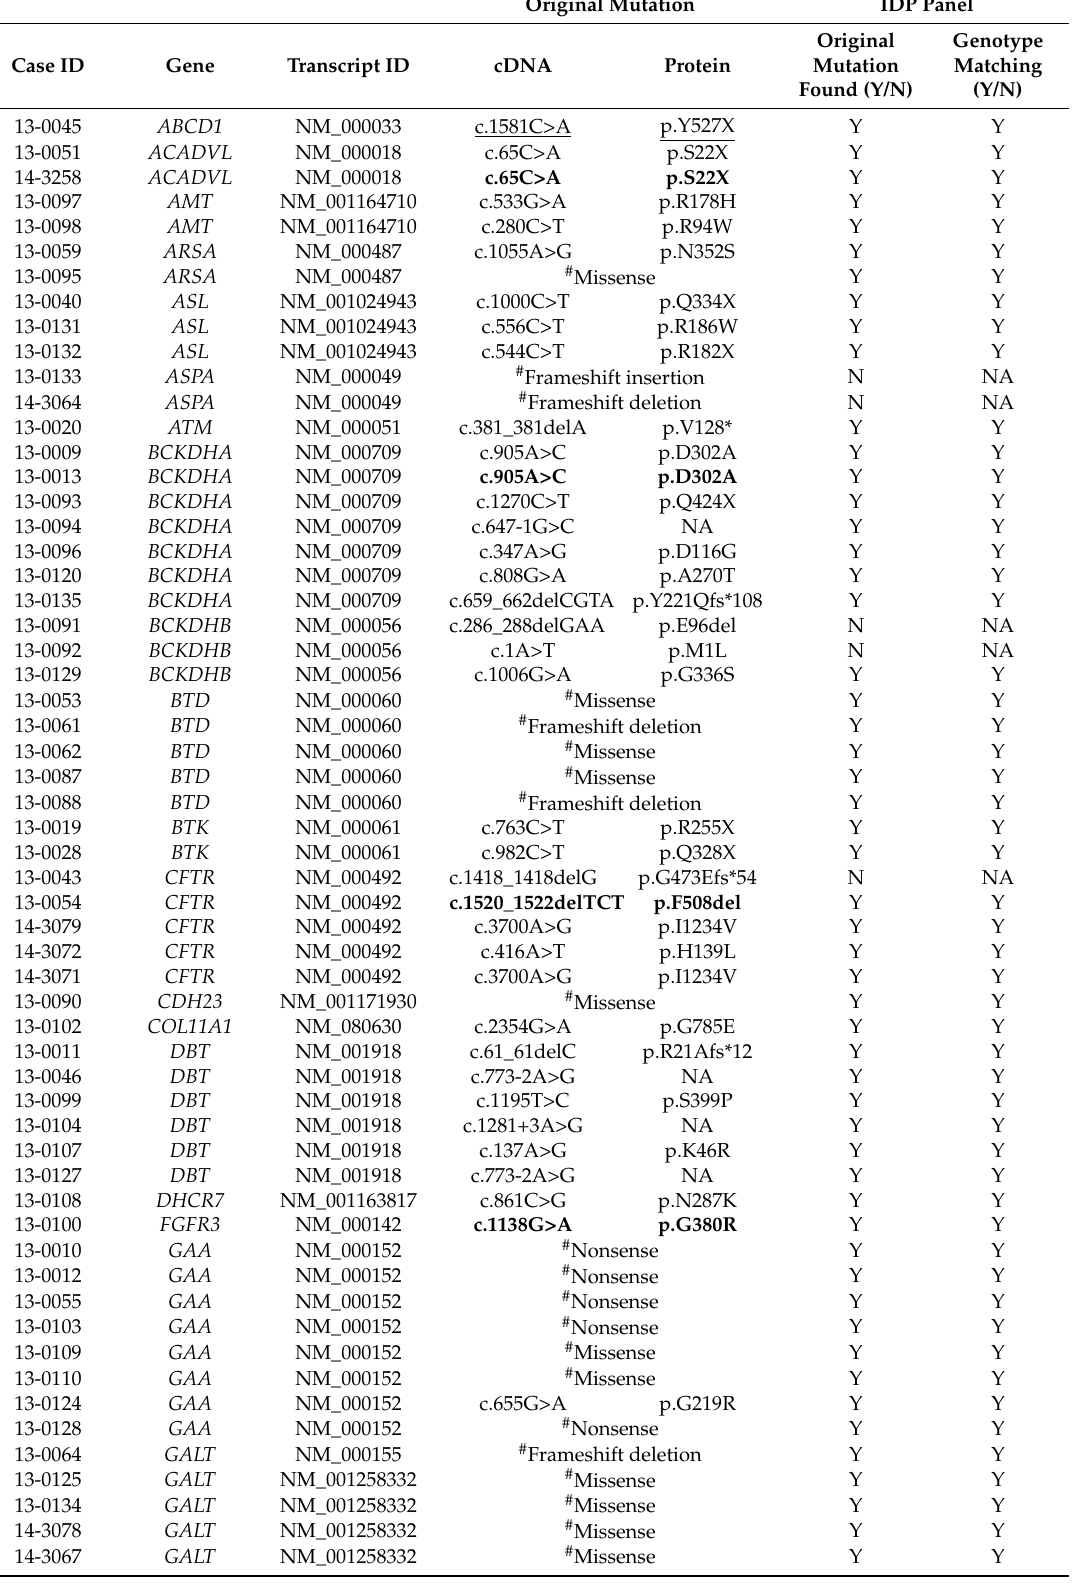
Table 2. List of mutations detected by AmpliSeq Inherited Disease Panel